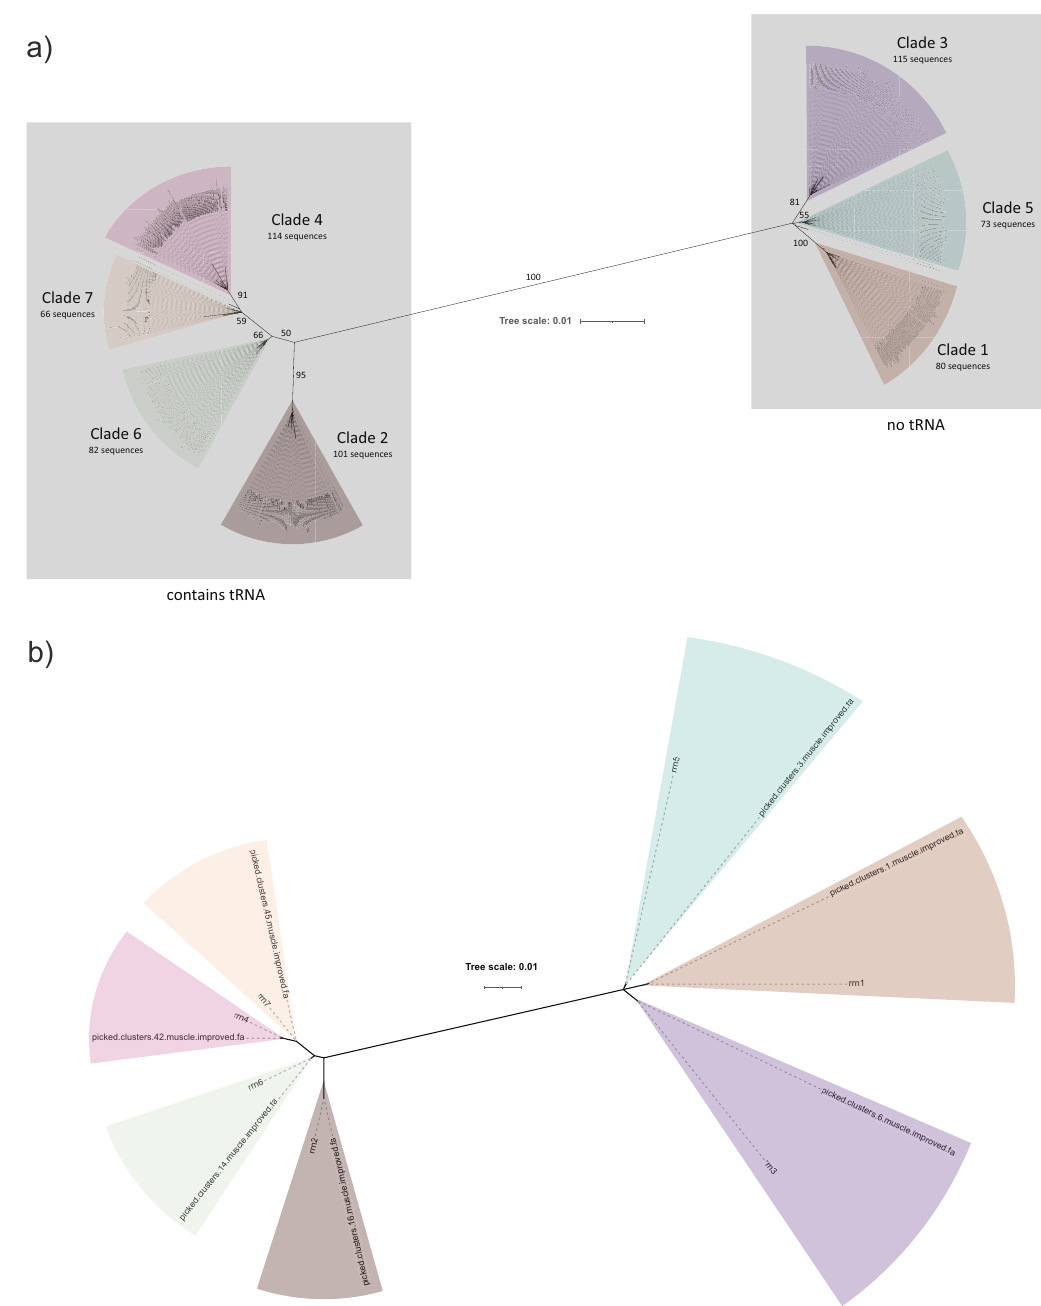
Fig. 2 Phylogenetic trees from E. coli . The tree scale shows the number of edits per base per unit length. a After two rounds of clustering, 628 E. coli RoC-ITS sequences (out of 708 initial reads) were combined with the seven E. coli K12 reference 16S-ITS sequences, multiply aligned, and converted into an unrooted phylogenetic tree. Bootstrap values are shown for the primary branches. Each of the seven highlighted clades corresponds to one of the reference 16S-ITS sequences, numbered based on their distance from the origin (closest to furthest), along with the number of RoC-ITS sequences associated with each clade. b Consensus sequences after clustering RoC-ITS sequences at 99.5% identity. The unrooted phylogenetic tree shows these consensus sequences along with the E. coli K12 reference 16S-ITS frequencies of 100% among the relevant RoC-ITS sequences. This recapitulate all seven individual rrns, clustering at 99.2% or greater either points to errors in the reference genome or, more likely, to identity was required. The resulting consensus rrns are almost evolution within the sub-strain used for this experiment. identical to the expected rrns (Fig. 2b) with two of the consensus We examined the number of RoC-ITS sequences associated sequences differing from expectation by a single base substitution. with each rrn cluster (Supplemental Table 3). Even with random Careful examination of the MSAs associated with these differences sampling, a statistical test rejected the null model where each reveal that the differences were not due to simple indels, often rrn cluster should be equally abundant ( χ 2 test, P = 2.64E-04). a source of error in Nanopore reads and frequently associated with polynucleotide stretches, but rather base substitutions with